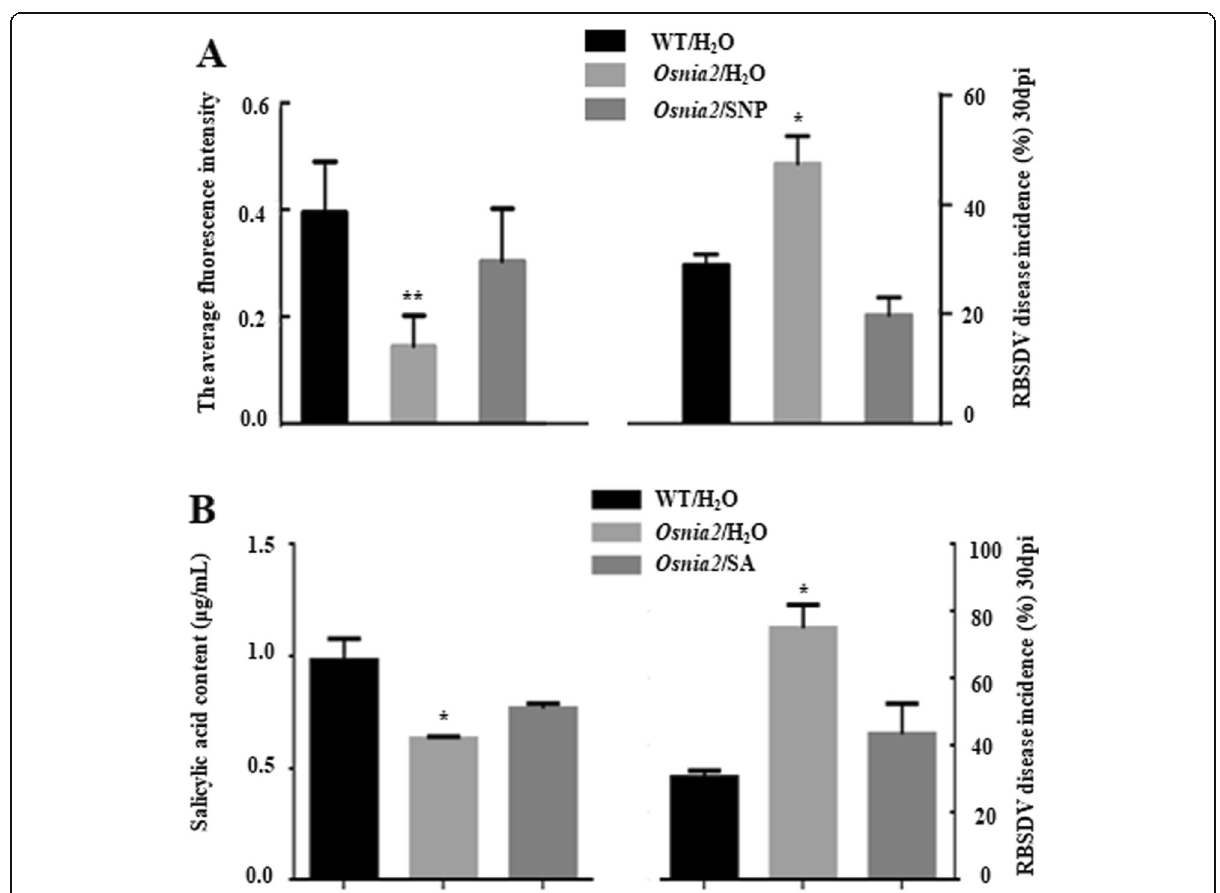
Fig. 6 RBSDV disease incidence and NO production in rice cv. Dongjing (WT) and Osnia2 mutant plants. a Left. NO production in the SNP-treated RBSDV-inoculated Osnia2 mutant plants and RBSDV-inoculated Dongjing and Osnia2 mutant. NO production analysis was assessed as described in Fig. 3. Ten plants were analyzed as ten biological replicates per treatment. The data represented the means ± SD of the ten replicates. Entire experiment repeated 3 times with similar results. Right. Dongjing and Osnia2 mutant rice plants were pre-treated with SNP followed by RBSDV inoculation. Disease incidences of Dongjing and Osnia2 mutant rice were determined from three independent experiments with 30 plants per treatment. The data represented the means ± SD of the three replicates. b Left. The amount of endogenous SA in the SA-treated RBSDV- inoculated Osnia2 mutant plants and RBSDV-inoculated Dongjing and Osnia2 mutant. The data represented the means ± SD of the three replicates. Entire experiment repeated 3 times with similar results. Right. Dongjing and Osnia2 mutant rice plants were pre-treated with SA followed by RBSDV inoculation. Disease incidences of Dongjing and Osnia2 mutant rice were determined from two independent experiments with 30 plants per treatment. The data represented the means ± SD of the two replicates. Statistical differences between the treatments were determined by the Duncan ’ s multiple test, p < 0.01 or p <